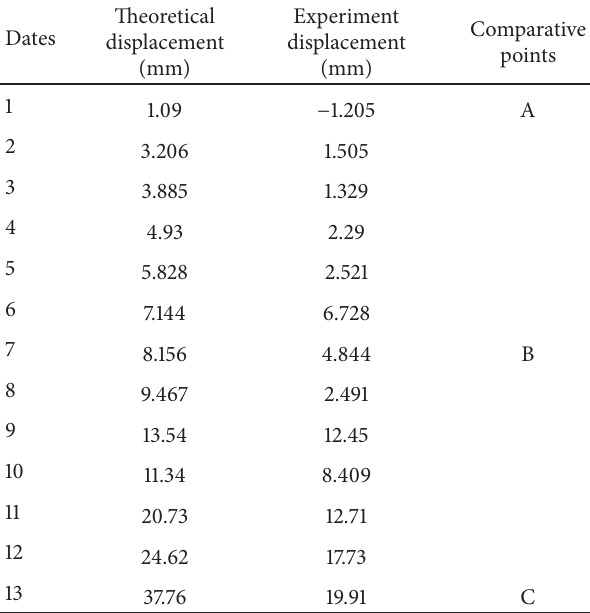
Table 4: Comparison analysis between the theoretical displacement and experimental